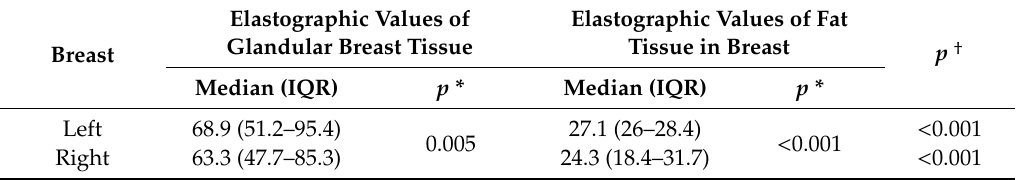
Table 4. Comparison of elastographic values of glandular and fat tissue in left and right breast. Elastographic Values Breast